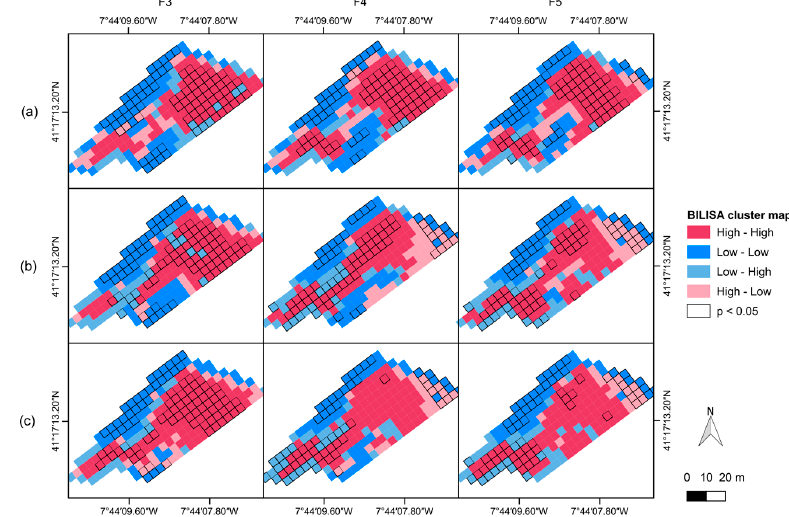
Figure 12. BILISA cluster maps between NDVI vigour maps and CWSI maps for the three evaluated approaches: ( a ) first approach, ( b ) second approach, and ( c ) third approach. Associations with a p -value < 0.05 are highlighted with a black border.